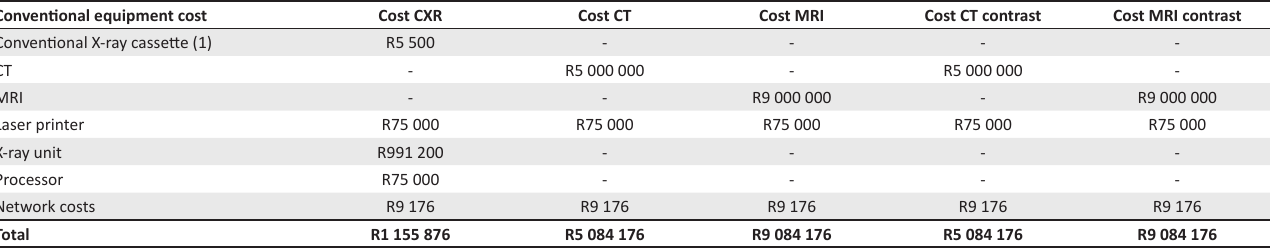
TABLE 3: Overall costs for chest radiographs and CT and MRI brain scans using the conventional radiography